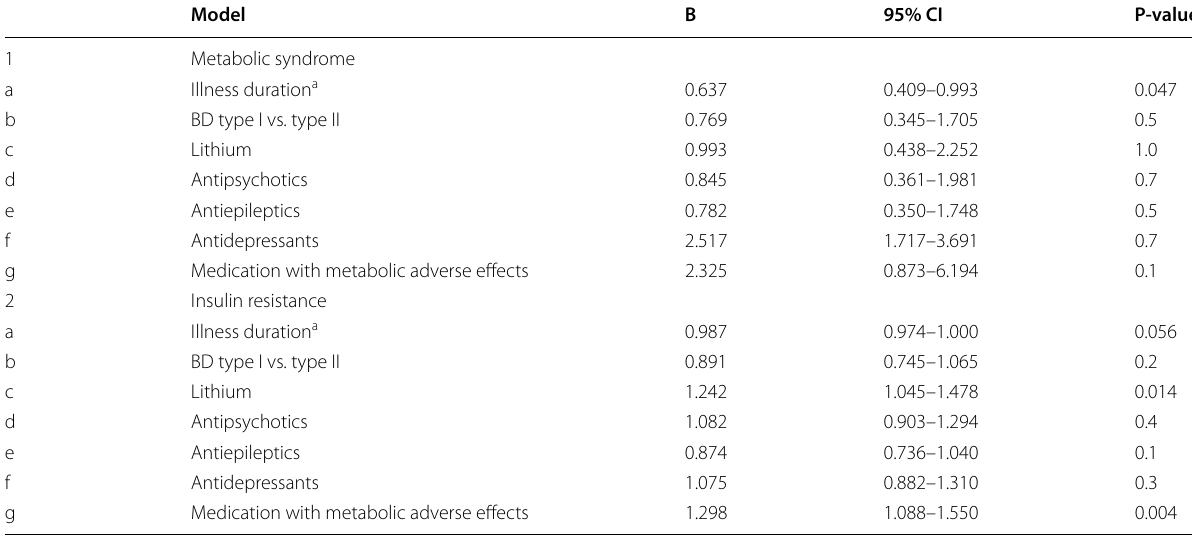
Model 1: Separate generalized linear mixed models of metabolic syndrome (a–g) in patients with BD, adjusted for age and sex. B represents odds ratios Model 2: Separate linear mixed models of insulin resistance (a–g) in patients with BD, adjusted for age and sex. B represents back transformed beta values BD I and BD II: Bipolar Disorder type I and II, respectively. a Illness duration was defined as time from first episode (depressive, hypomanic, manic or mixed